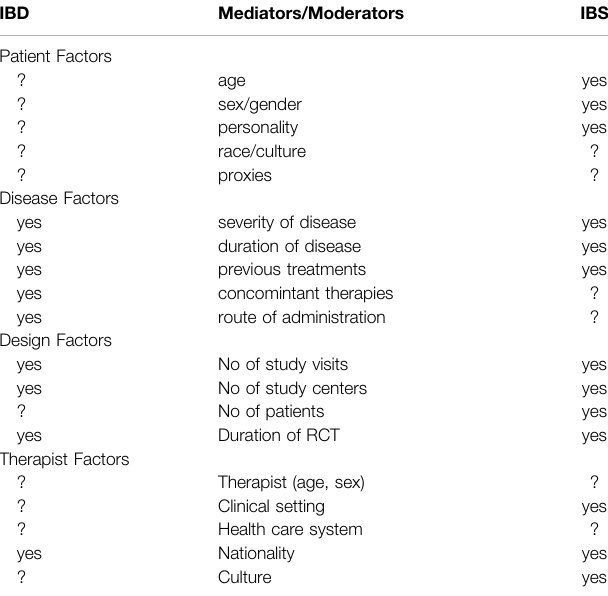
TABLE 2 | Mediators and moderators of the placebo response in RCT in in fl ammatory bowel diseases (IBD) and the irritable bowel syndrome (IBS) and other functional gastrointestinal disorders, as evidenced (yes) in this and in previous reviews (e.g. Enck and Klosterhalfen 2020); question marks indicate a lack of